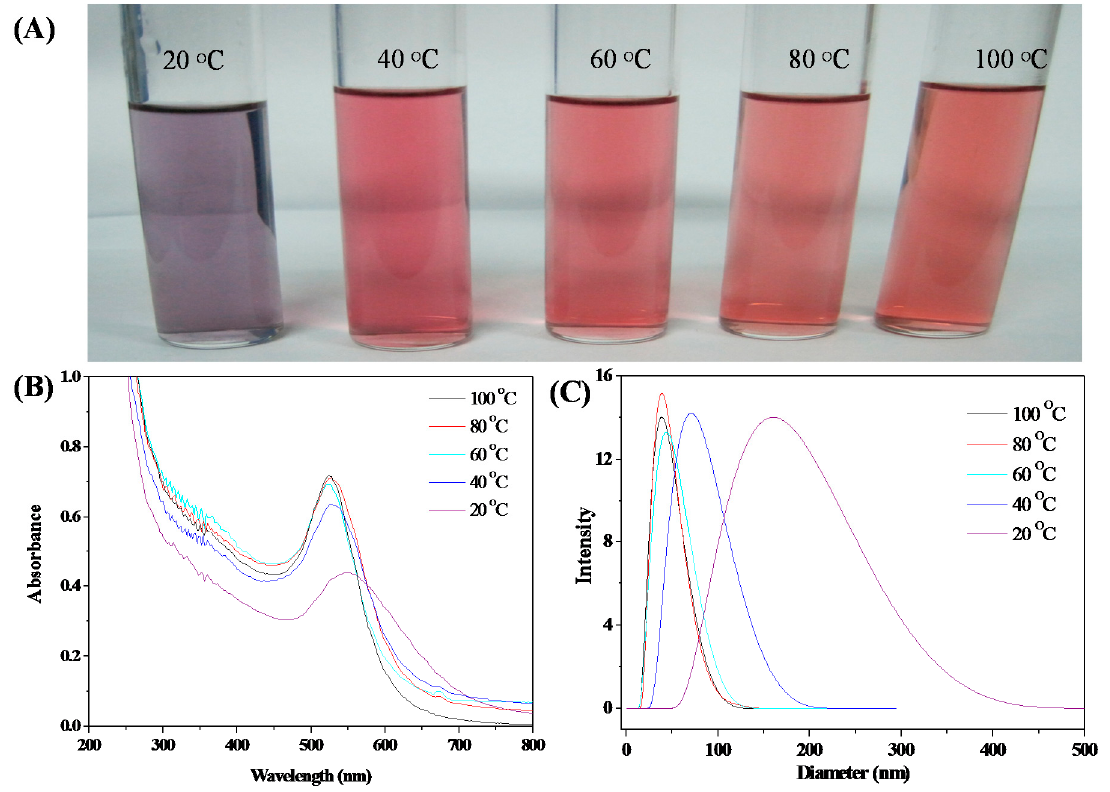
Figure 2. ( A ) Photographs, ( B ) UV-Visible spectra, and ( C ) DLS diagram of HPEI-IBAm functionalized AuNPs when the preparation temperature increased from 20 to 100 °C.